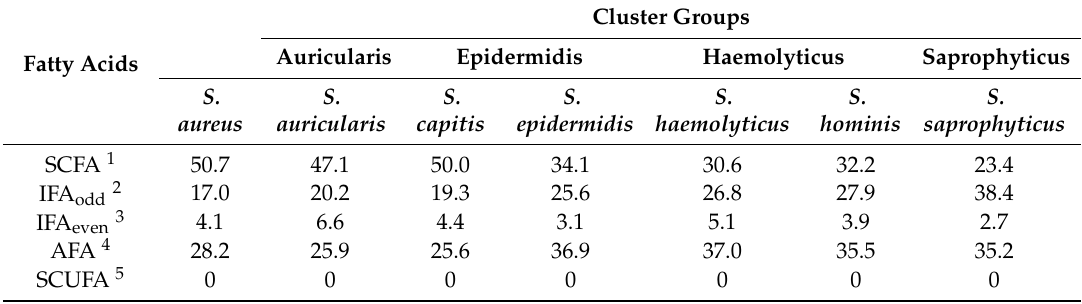
Fatty acid composition (%) of Tryptic Soy Broth-grown coagulase-negative staphylococcal